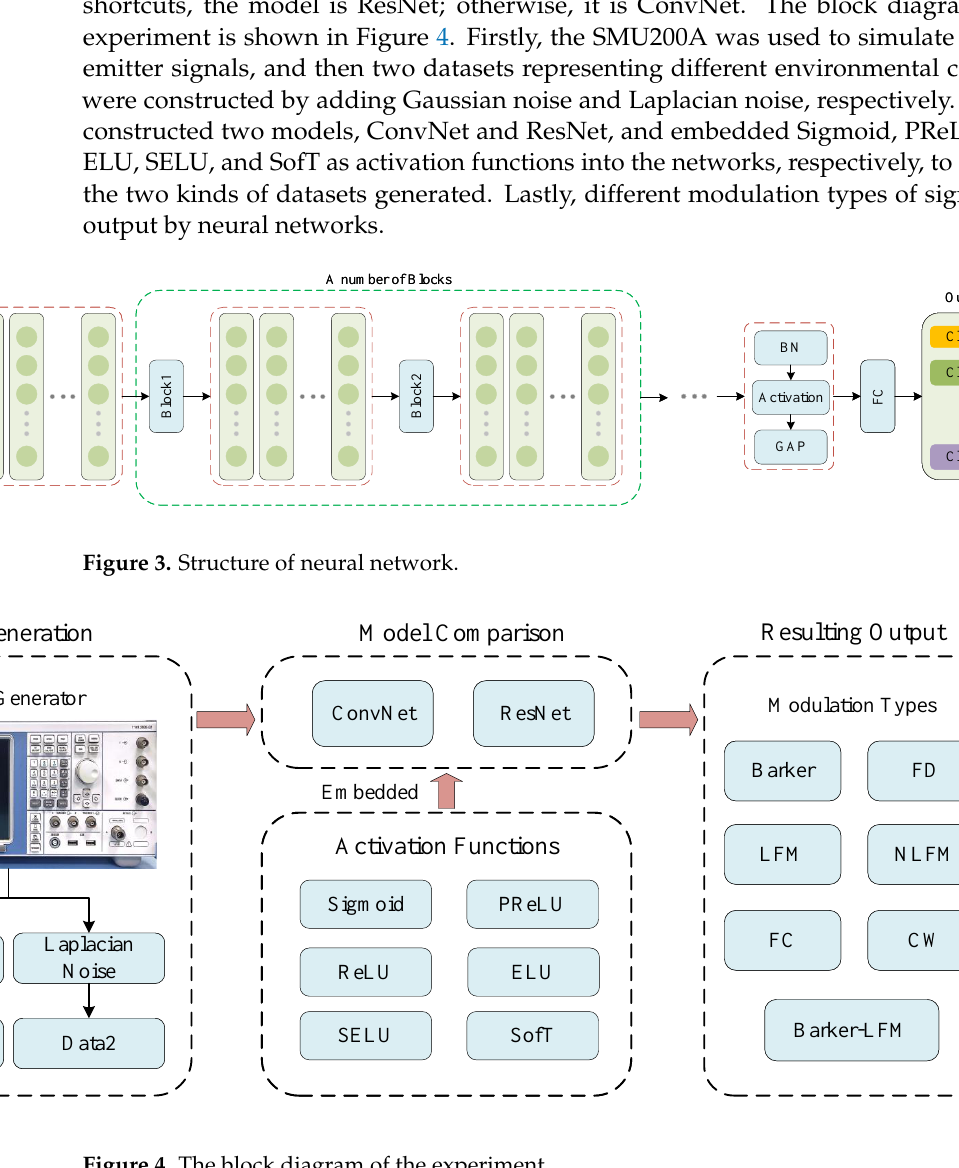
Figure 4. The block diagram of the